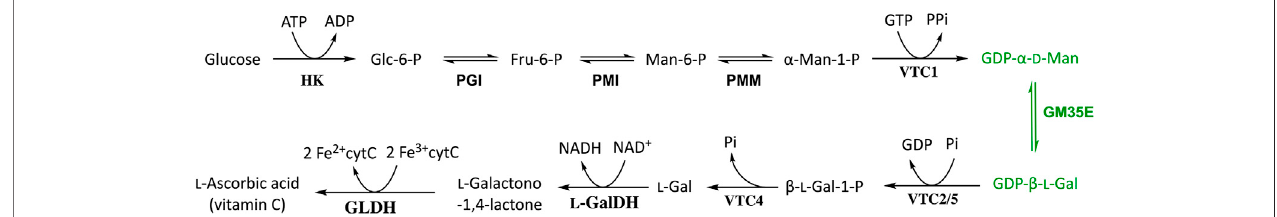
FIGURE 1 | Schematic overview of L -ascorbate biosynthesis in photosynthetic organisms, known as the Smirnoff-Wheeler pathway, with the GM35E (GDP-Man 3,5-epimerase) highlighted in green. HK, hexokinase; PGI, phosphoglucoisomerase; PMI, phosphomannoisomerase; PMM, phosphomannomutase; VTC1, GDP-Man pyrophosphorylase; VTC2/5, GDP- L -Gal phosphorylase; VTC4, L -Gal-1-P phosphatase; L -GalDH, NAD + -dependent L -galactose dehydrogenase; GLDH, ferric cytochrome C-dependent L -galactono-1,4-lactone dehydrogenase.